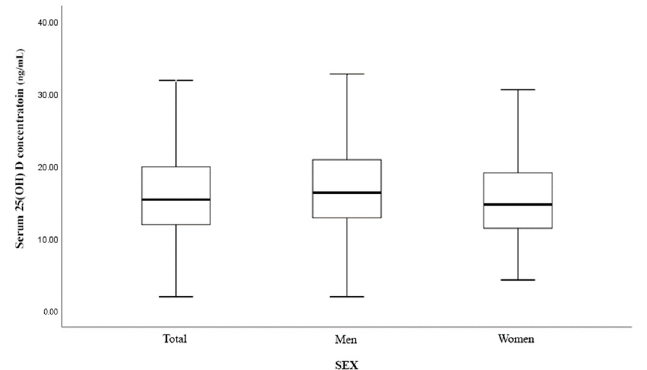
Figure 2. Distribution of serum 25-hydroxyvitamin D (25(OH)D) concentration of participants. Median is represented by the line in the box. The interquartile range box represents the middle 50% of the distance (Q3–Q1) between the first and third quartiles (25th percentile and 75th percentile). The connecting lines of the boxes are the minimum and maximum values.